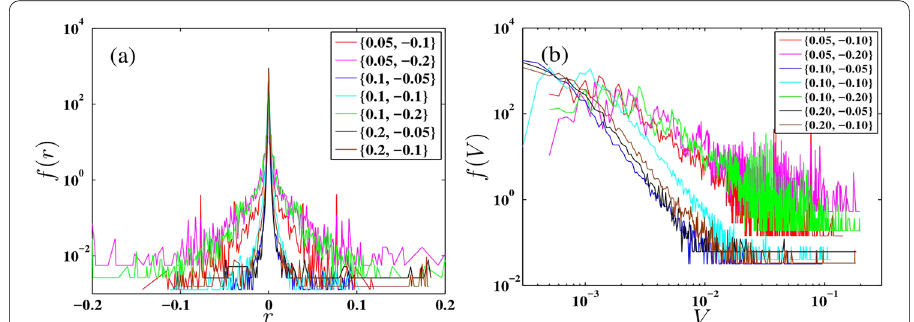
Fig. 8 Empirical distributions of returns in linear‑log coordinates ( a ) and absolute returns in log‑log scales ( b ) for the stocks simulated for different combinations of price limits